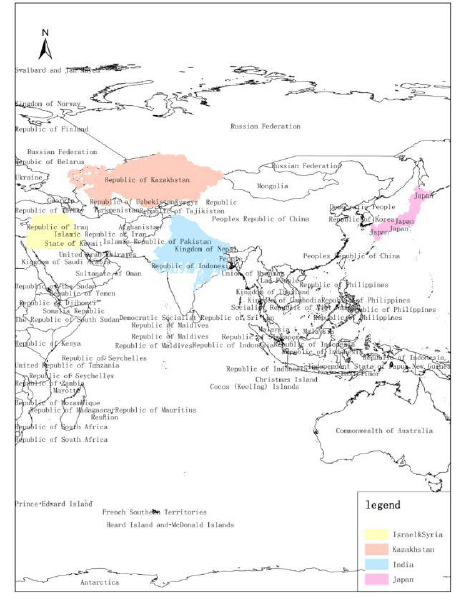
Figure 1. Study areas and the location of horizontal accuracy assessment of Google Earth